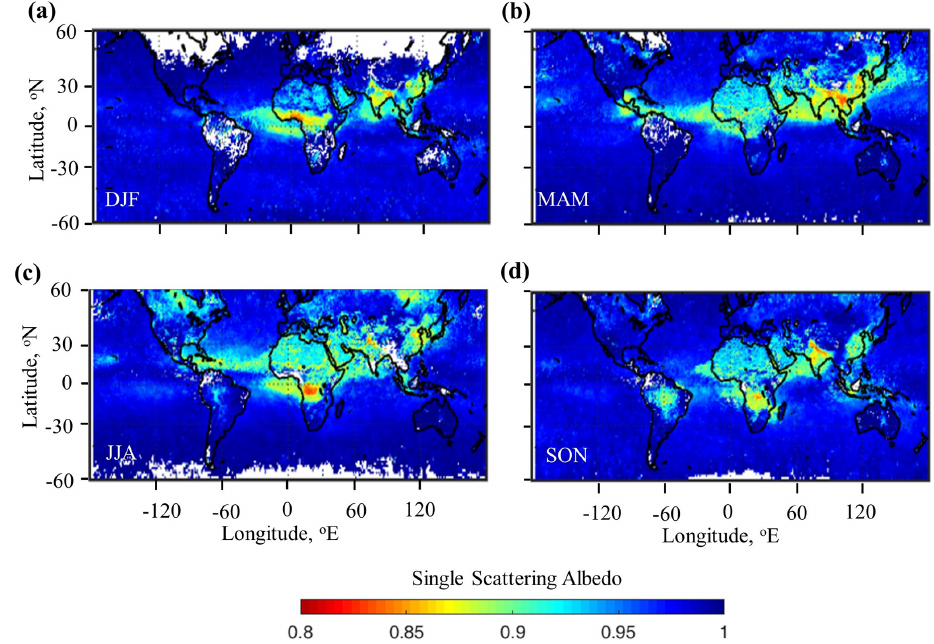
Figure 4. Seasonal mean SSA maps for the period 2014–2018 retrieved by the combined CERES-MODIS, for (a) December–January– February (DJF), (b) March–April–May (MAM), (c) June–July–August (JJA), and (d) September–October–November